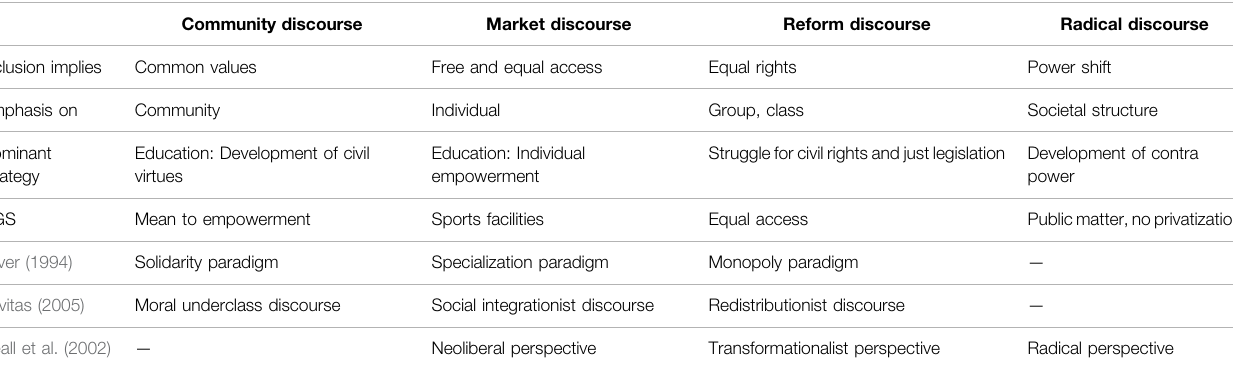
TABLE 2 | Four discourses on exclusion (inclusion) composed on the basis of Silver (1994), Beall et al. (2002) and Levitas